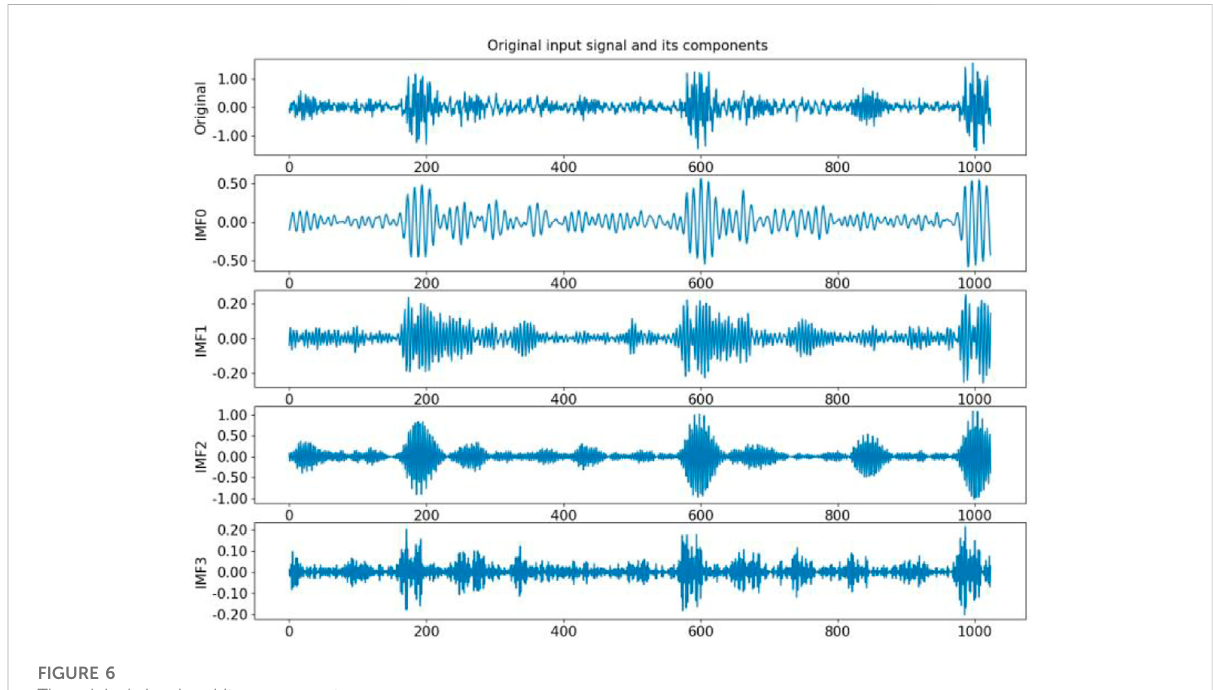
FIGURE 6 The original signal and its